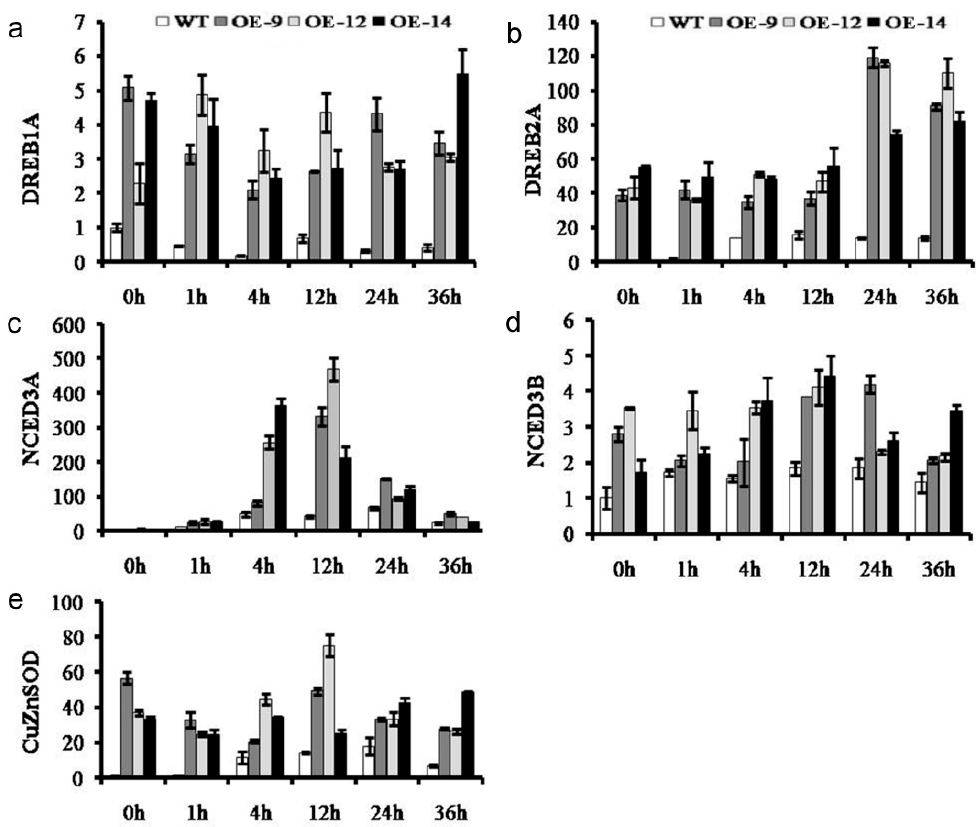
Figure 5. The relative expression of abscisic acid (ABA)-responsive genes DREB1A ( a ), DREB2A ( b ), NCED3A ( c ), NCED3B ( d ) and CuZnSOD ( e ) in wild-type and transgenic lines at various time points (0, 1, 4, 12, 24 and 36 h). Bars represent the standard deviation among three independent replicates. 2.6. Overexpression of CmWRKY10 Reduces Recactive Oxygen Species (ROS) Accumulation due to the Enhanced Activity of Superoxide Dismutase (SOD), Peroxide Dismutase (POD) and Catalase (CAT)